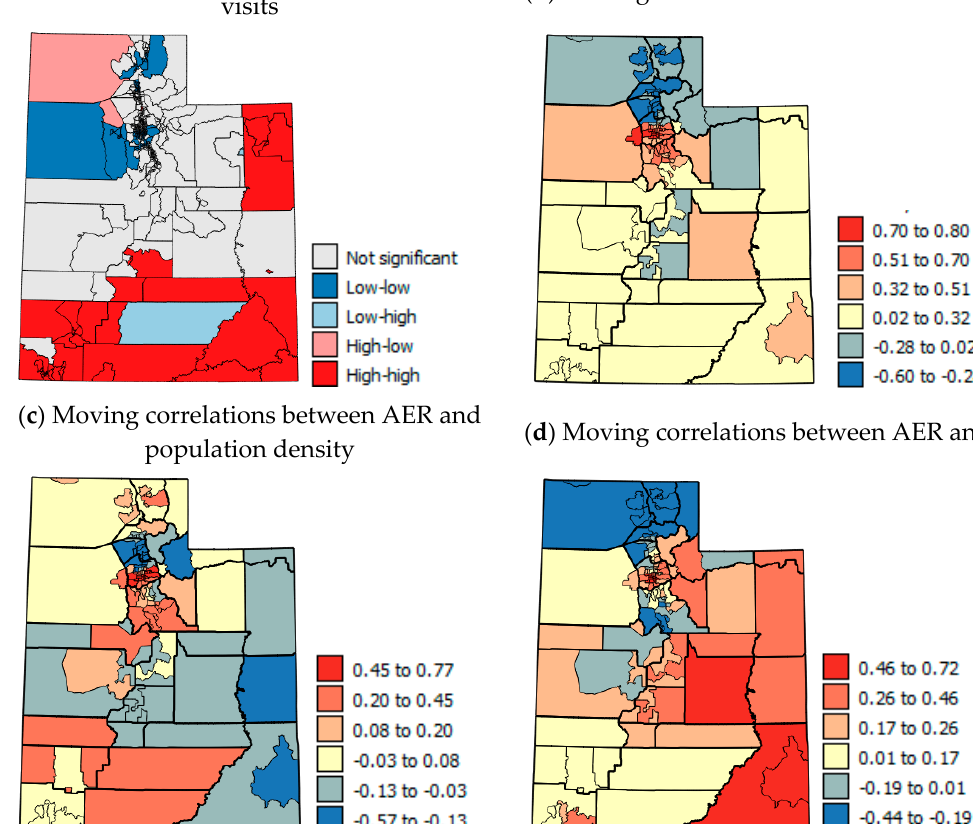
Figure 8. Local Moran’s I (LMI) and moving correlation analysis of RK AER visits and other variables.